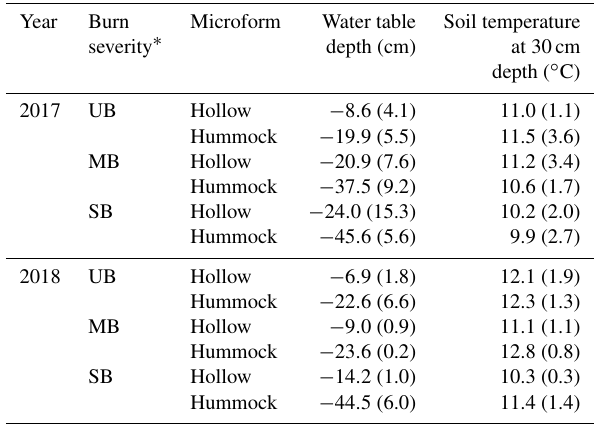
Table 1. Environmental characteristics (mean ( ± standard devia- tion)) for each microform type across the burn severity